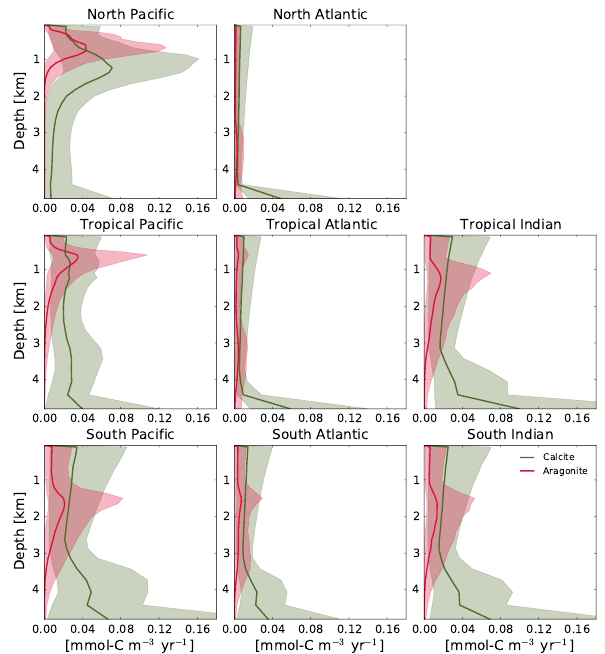
Figure 8. Constrained open water dissolution rate profiles for arag- onite (red) and calcite (olive). Ensemble medians (solid lines) and 68% confidence intervals (shadings) are for spatial averages across individual regions and only include grid cells where the model wa- ter column extends to a depth of